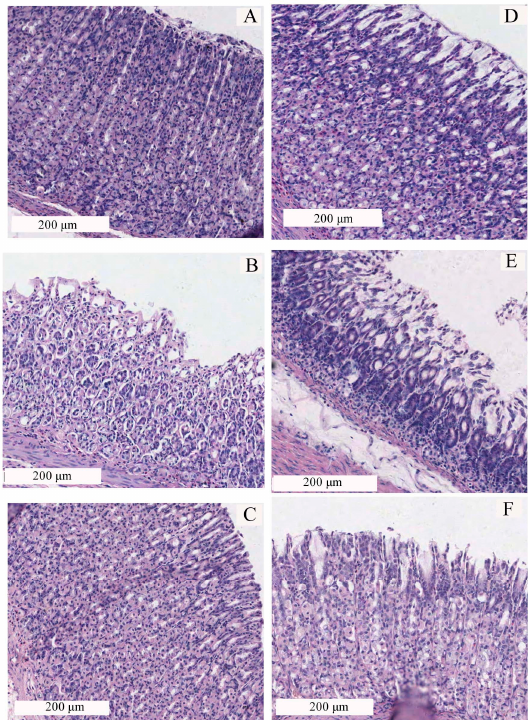
Figure 6 . Histological sections of different treatments against ethanol-induced gastric lesions (Original magnification 200×). ( A ) Normal; ( B ) Ethanol; ( C ) CP-A 50 mg/kg + Ethanol; ( D ) CP-A 25 mg/kg + Ethanol; ( E ) CP-A 12.5 mg/kg + Ethanol and ( F ) BPC + Ethanol.